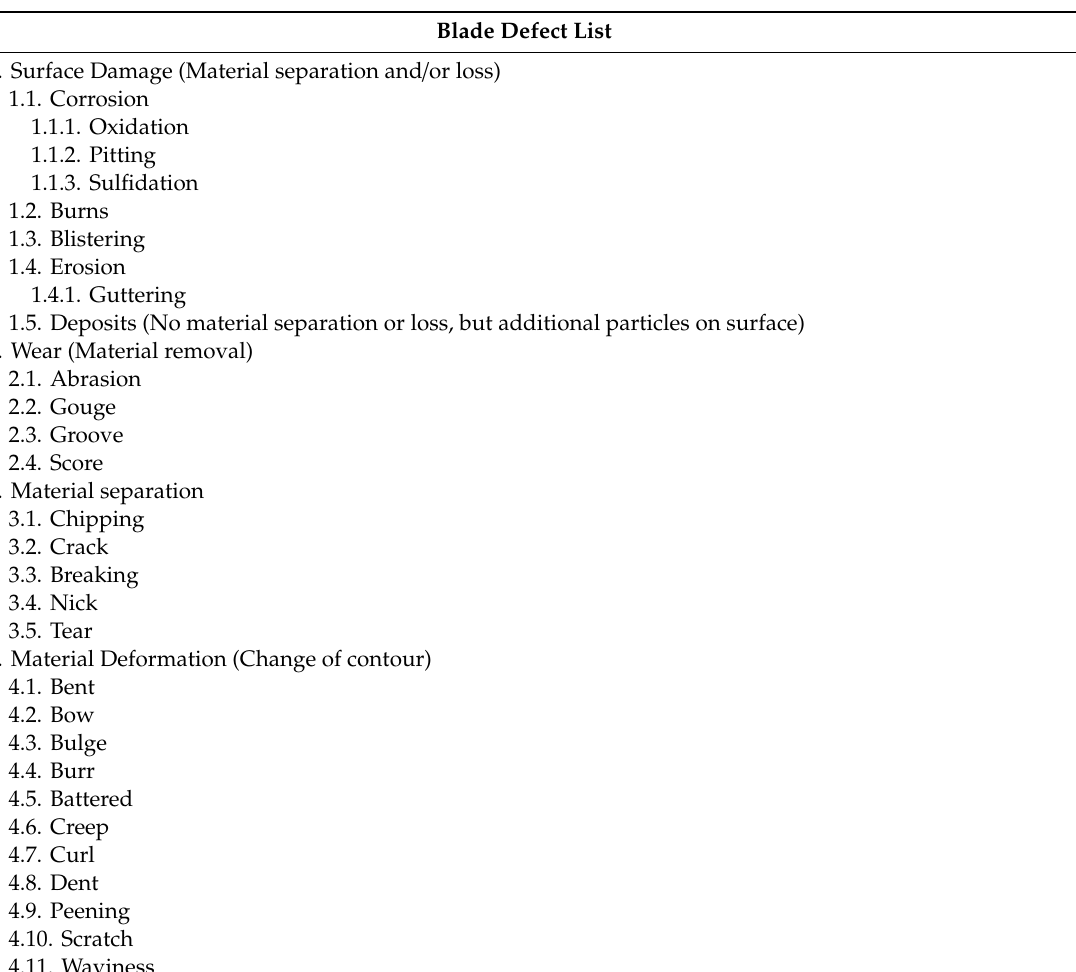
Table 2. Engine Blade Defects categorised by the Type of Damage. Blade Defect